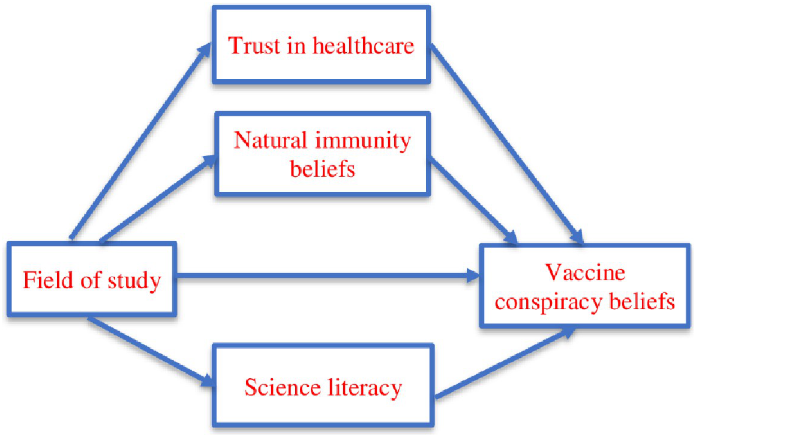
Fig 1. Conceptual diagram of the parallel mediation tested in the